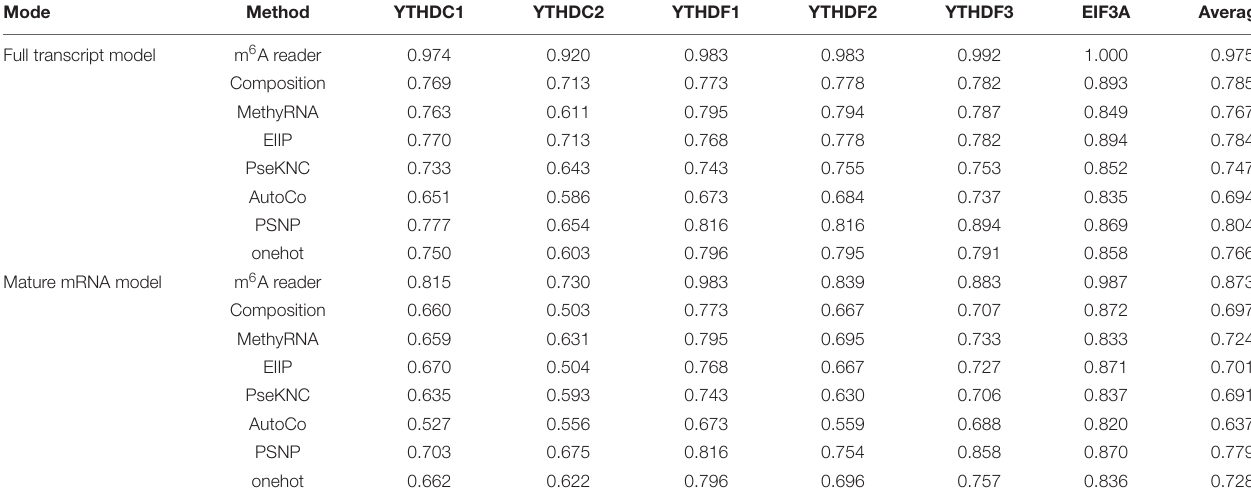
TABLE 3 | Target prediction performance under cross-condition test.